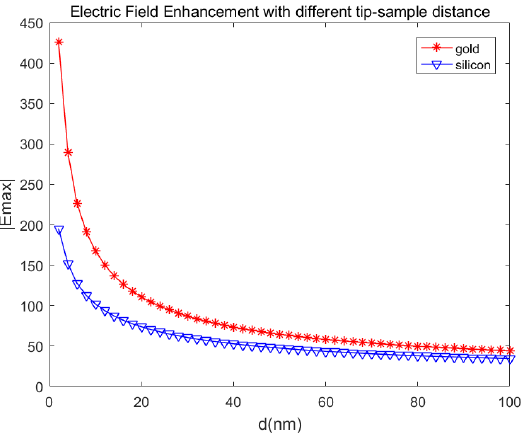
Figure 3. Electric field enhancement with different tip-sample distance.